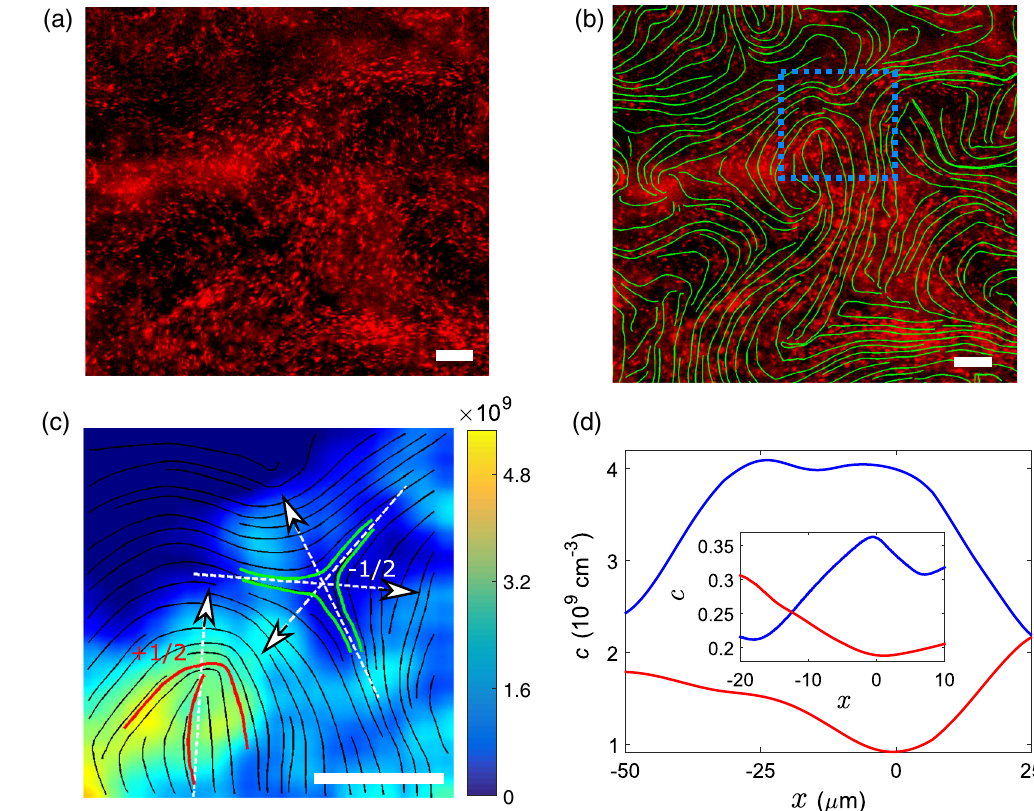
FIG. 5. Experimental verification. (a) Fluorescent image of swimming bacteria suspended in a freestanding LC film in the regime of chaotic motion. Average bacterial concentration c ≈ 2 × 10 9 cell = cm 3 . Scale bar is 50 μ m. See also Videos 5 and 8 in Supplemental Material [39]. (b) Digitally processed image of (a). Green lines show the LC nematic director orientation reconstructed from the bacterial orientation. Several defects are present. (c) Bacterial concentration distribution in the area indicated by the blue dashed box in (b). Colors represent the concentration of bacteria extracted from the averaged fluorescence intensity. Two topological defects ( 1 = 2 and − 1 = 2 ) are highlighted. White lines show defect orientations. Scale bar is 50 μ m. (d) Bacterial concentration profiles around the defects. Blue line represents a concentration profile in the vicinity of 1 = 2 defect along the white dashed line in (d). x ¼ 0 corresponds to the center of 1 = 2 defect. The red line represents a concentration profile in the vicinity of − 1 = 2 defect. Concentration profiles along three white dashed lines are averaged. Inset: Bacterial concentration profiles along the lines passing through the cores of defects extracted from the computational model for c 0 ¼ 0 . 3 , τ ¼ 66 . 6 and corresponding to Fig.